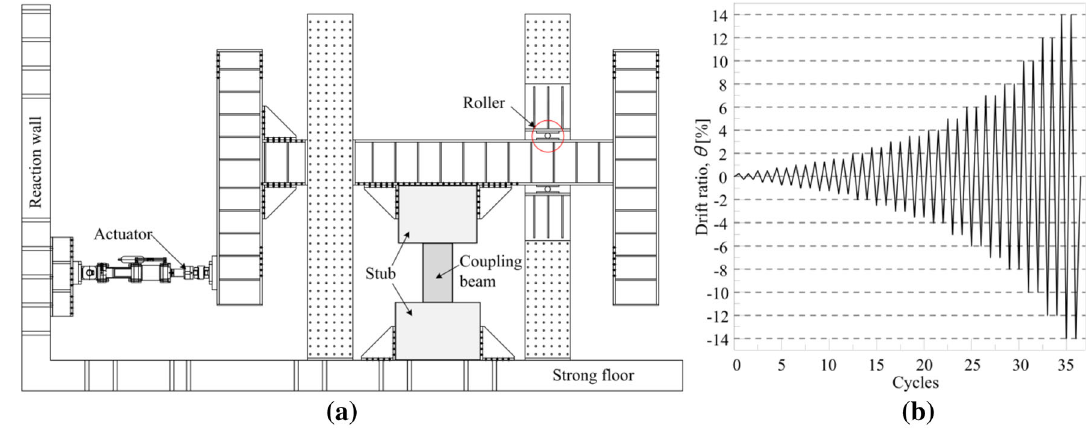
Fig. 4 Test setup and loading